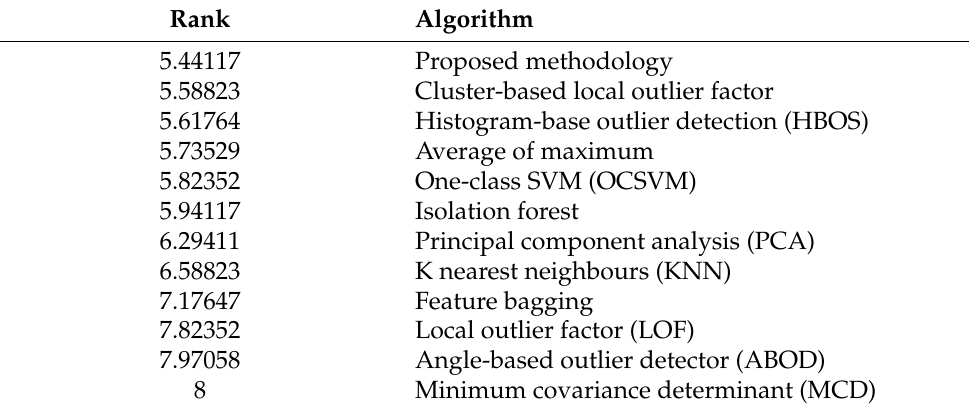
Table 2. Friedman comparison for